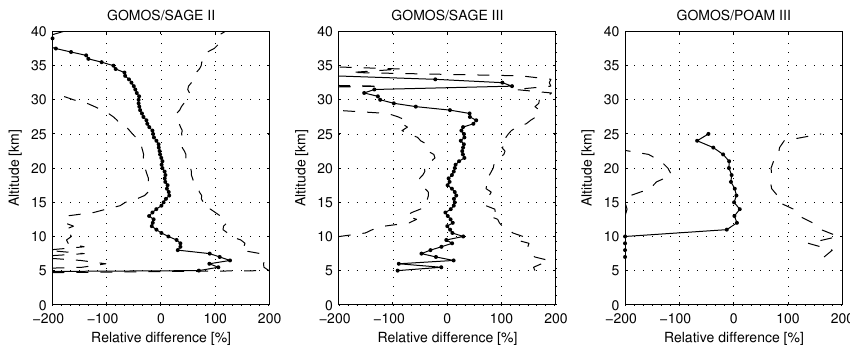
Fig. 3. Comparison of GOMOS aerosol extinction profiles with other satellite measurements: SAGE II at 525nm (left panel), SAGE III at 596nm (middle panel) and POAM III at 603nm (right panel). Shown are the statistics for the relative differences, calculated as 100 × 2 (p GOMOS − p SAT )/ | p GOMOS + p SAT | . The median of the set of relative differences is shown with full lines and dots. Dashed lines indicate the spread, given by the 16th and 84th